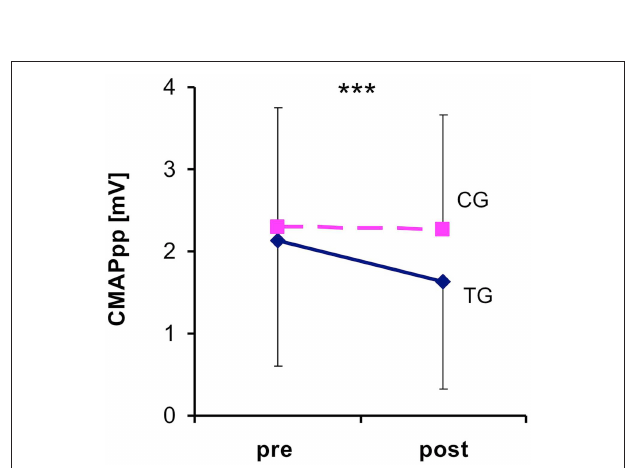
FIGURE 3 | Changes in the compound muscle action potential (CMAP pp ) size before the repetitive peripheral magnetic stimulation (rPMS) and post stimulation. The dashed line represents the control group (CG) and the continuous line indicates the treatment group (CG). Each bar corresponds to the SD value. Note that the reflex responses significantly decreased in size only after the rPMS in the treatment group. ***Denotes a significant difference between pre- and post-test (*** P ≤ 0.001) in